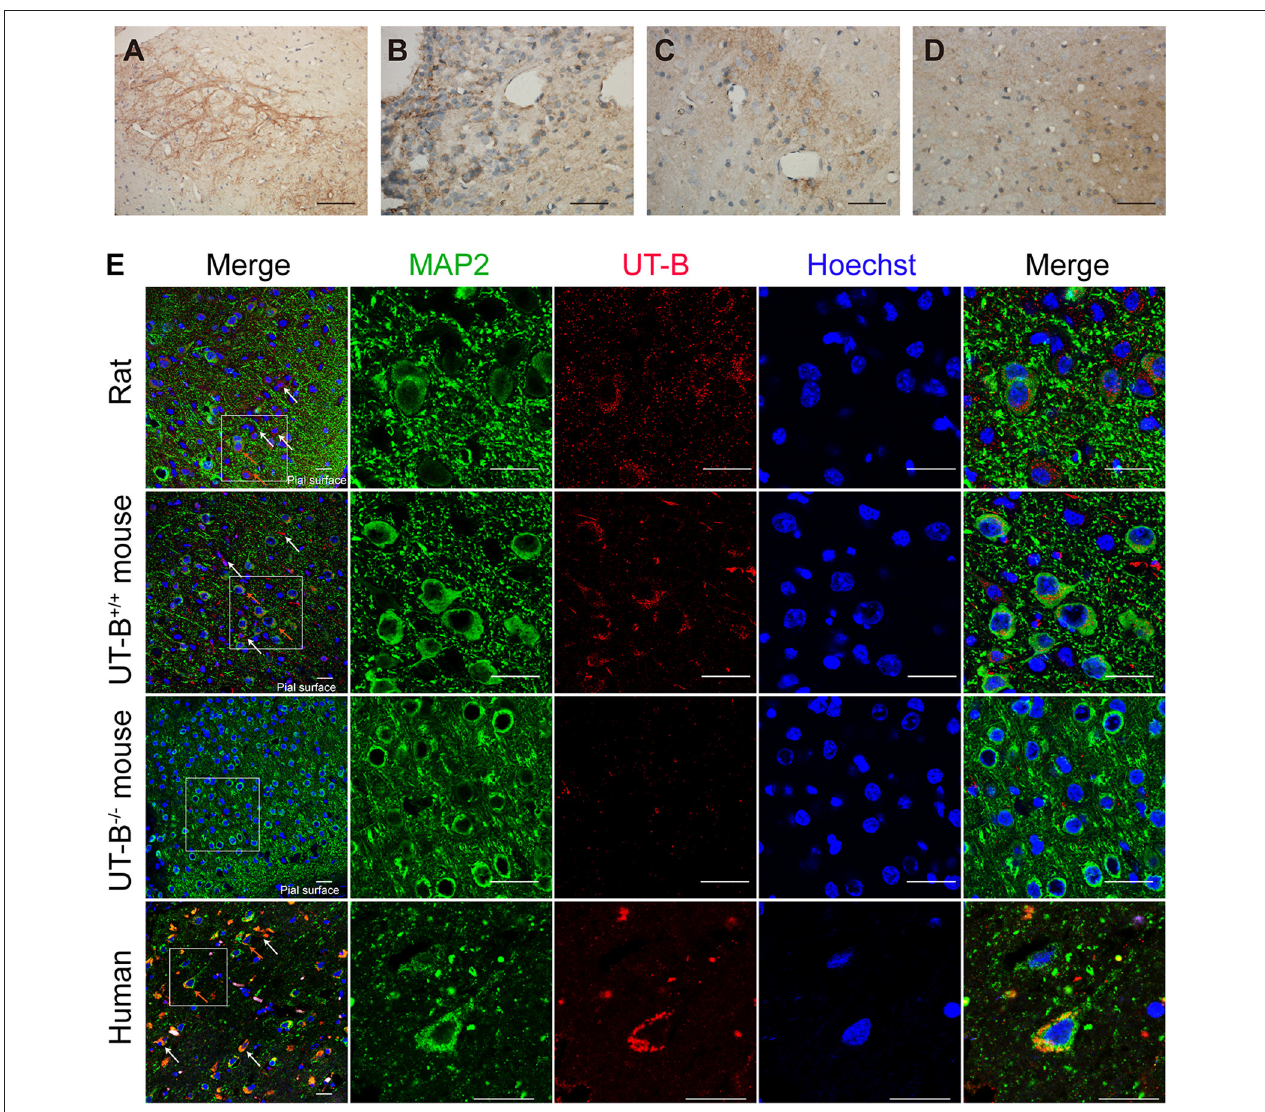
FIGURE 4 | UT-B is expressed in neurons. (a–d) Immunohistochemistry of substantia nigra, habenula, the lateral inferior nucleus of thalamus and cortex. Scale bar, 200 µ m. (e) Immunofluorescence revealed that UT-B (red) was expressed in MAP2-positive neurons (green) in rats, wild-type mice, UT-B knockout mice, and the human cerebral cortex. The cells indicated by the white arrows and the red stripe staining are positively stained astrocytes, and the orange arrows are the positively stained neurons. The pial surface is located in the lower right corner of the image. The large-field images of rats and mice mainly show the expression of UT-B in the three layers of the cerebral cortex, including molecular layer, external granule cell layer, and external pyramidal cell layer. Scale bar, 50 µ m. UT-B, urea transporter